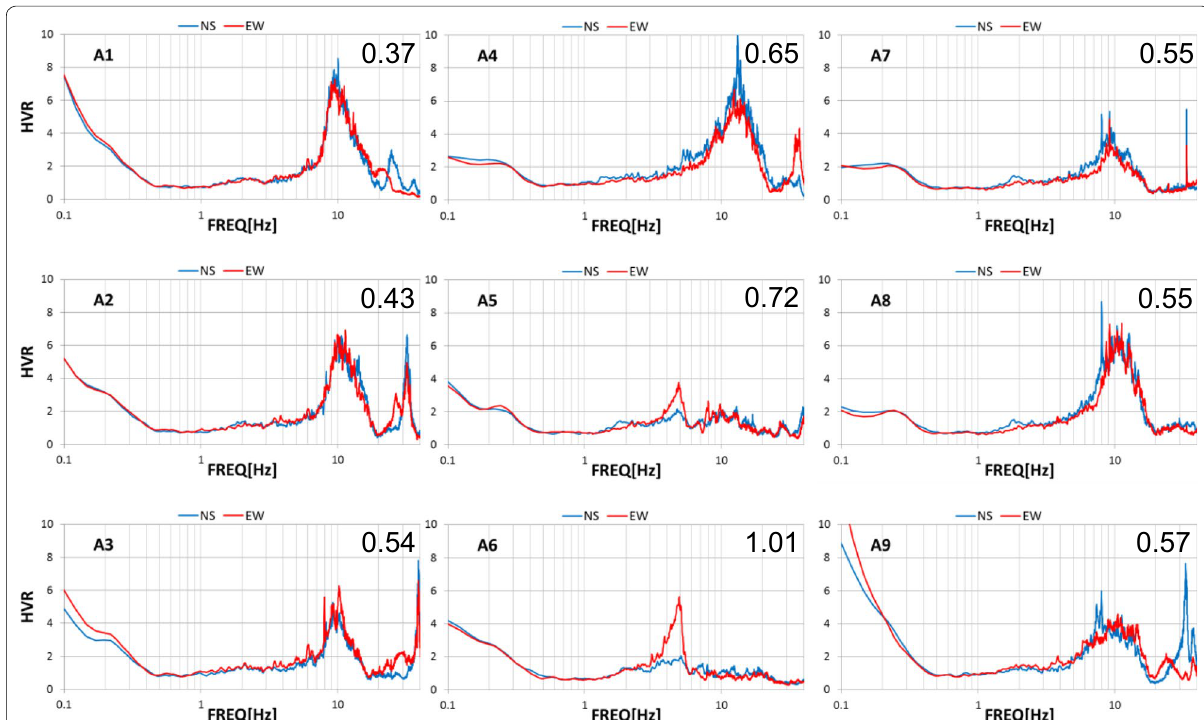
Fig. 6 Comparison of MHVRs along Line-A shown in Fig. 3. The figures from top-left to bottom-right are aligned from north to south on the survey line. Red and blue lines indicate NS/UD and EW/UD, respectively. The difference between the two is significant for points A-5 and A-6. The value of γ for each point is denoted in the right-top